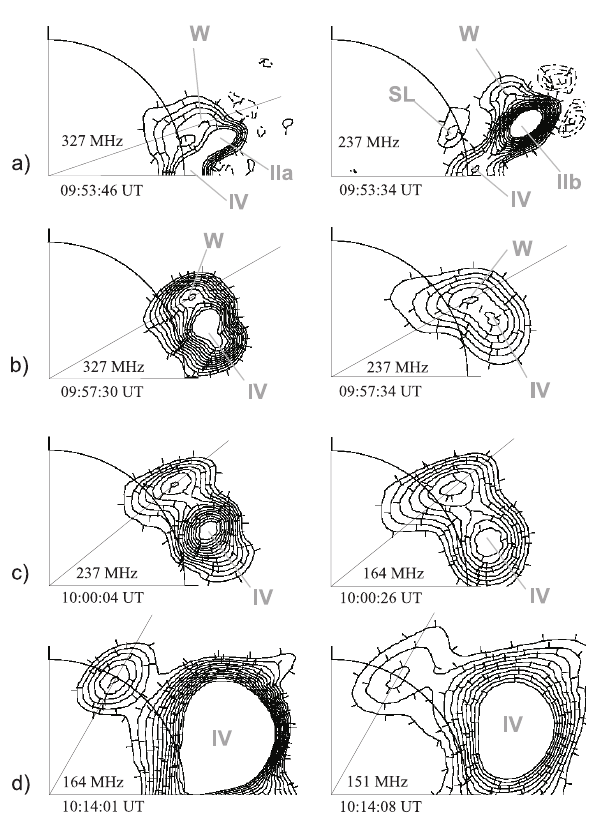
Figure 12: The coronal wave of 2003 Nov 3 imaged at metric wavelengths with the Nan¸cay radioheli- ograph. The wave source (marked 𝑊 ) is propagating northwards along the solar limb towards the pole. The type II and type IV burst sources are also indicated. In each panel, the observing time and frequency is given (adapted from Vrˇsnak et al. ,